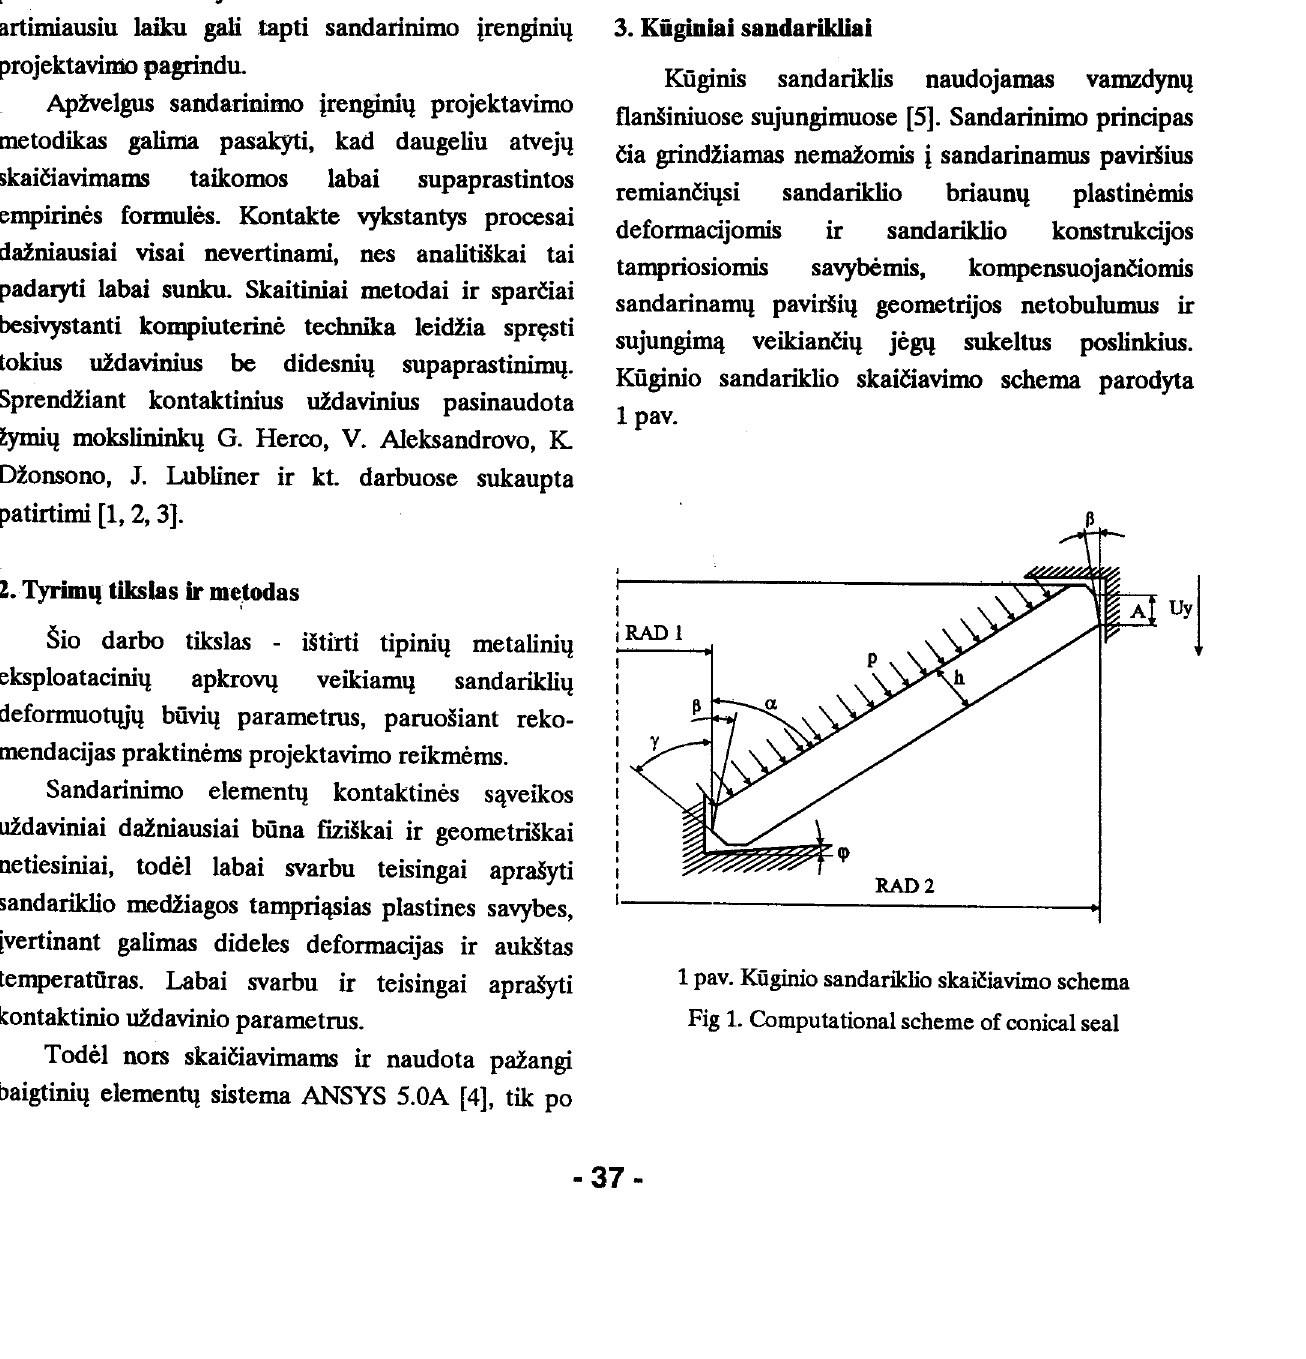
Fig 1. Computational scheme of conical